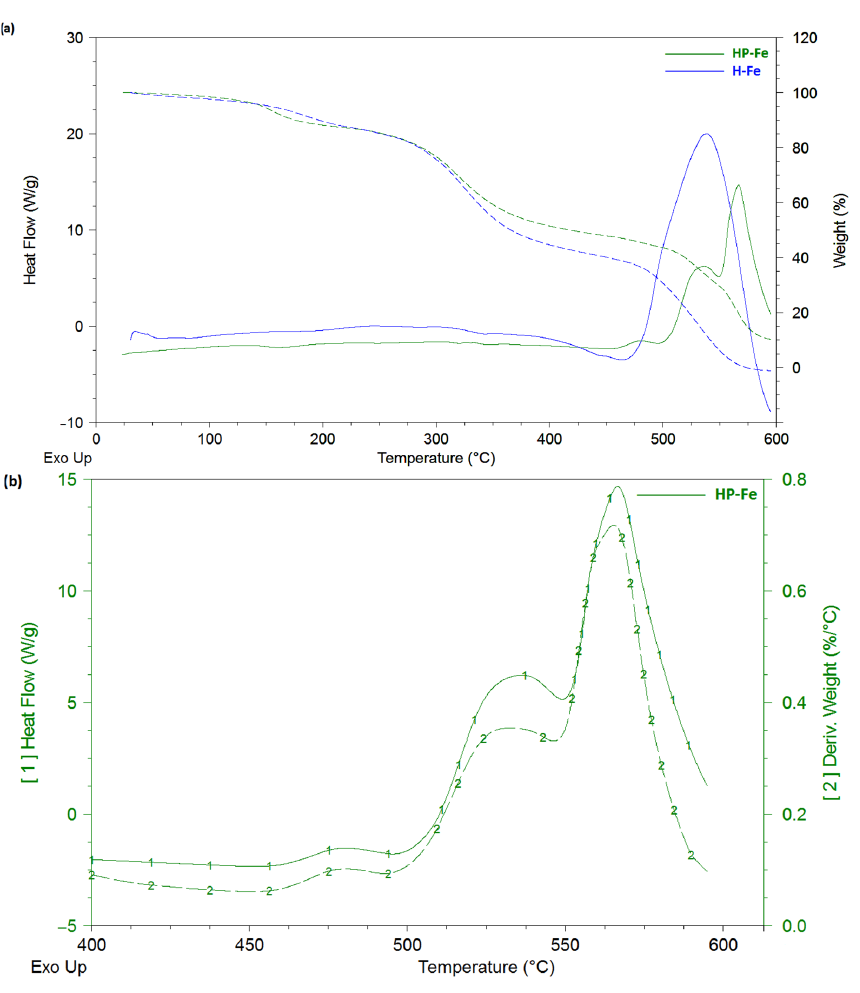
Figure 7. Thermal curves: ( a ) comparison of the thermal behavior of the HP ‐ Fe and H ‐ Fe hydrogels; ( b ) first heat and mass derivatives for HP ‐ Fe hydrogels.